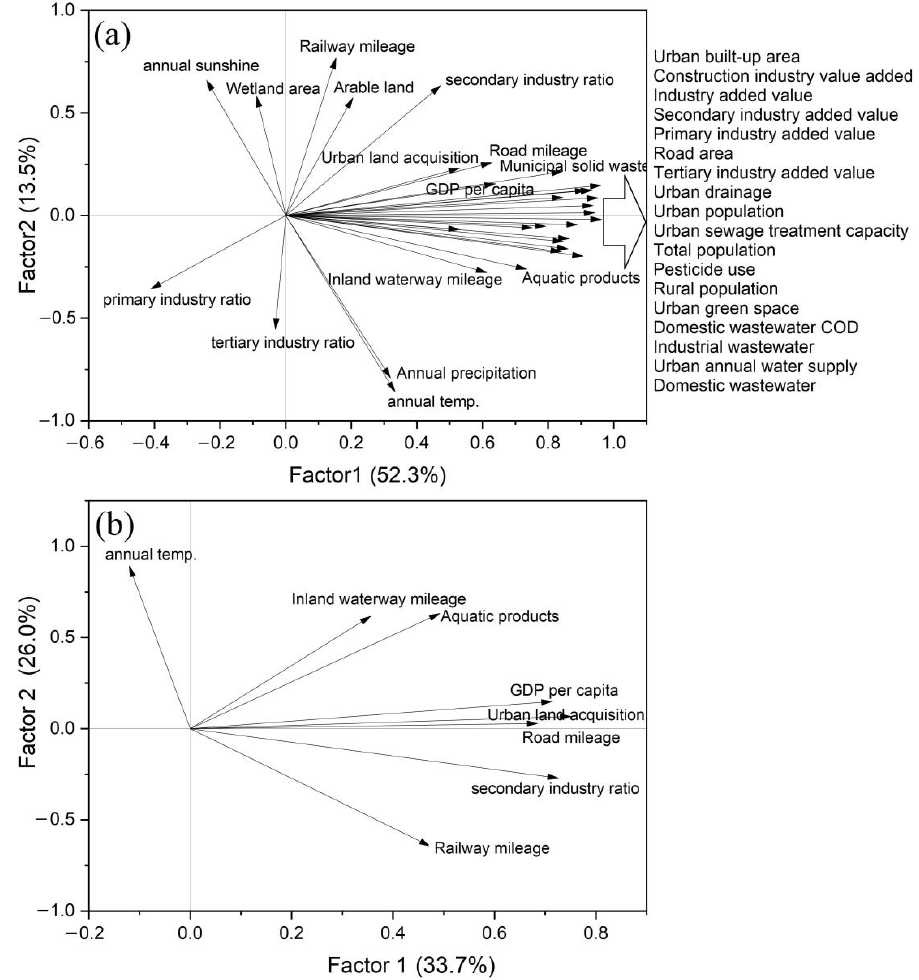
Figure 5. Factor analysis on changes in wetland areas: ( a ) all 32 factors, ( b ) the 8 most important factors. Table 1. Rotated loadings (Quartimax method) of the main climate and socioeconomic parameters on factors 1 and 2.